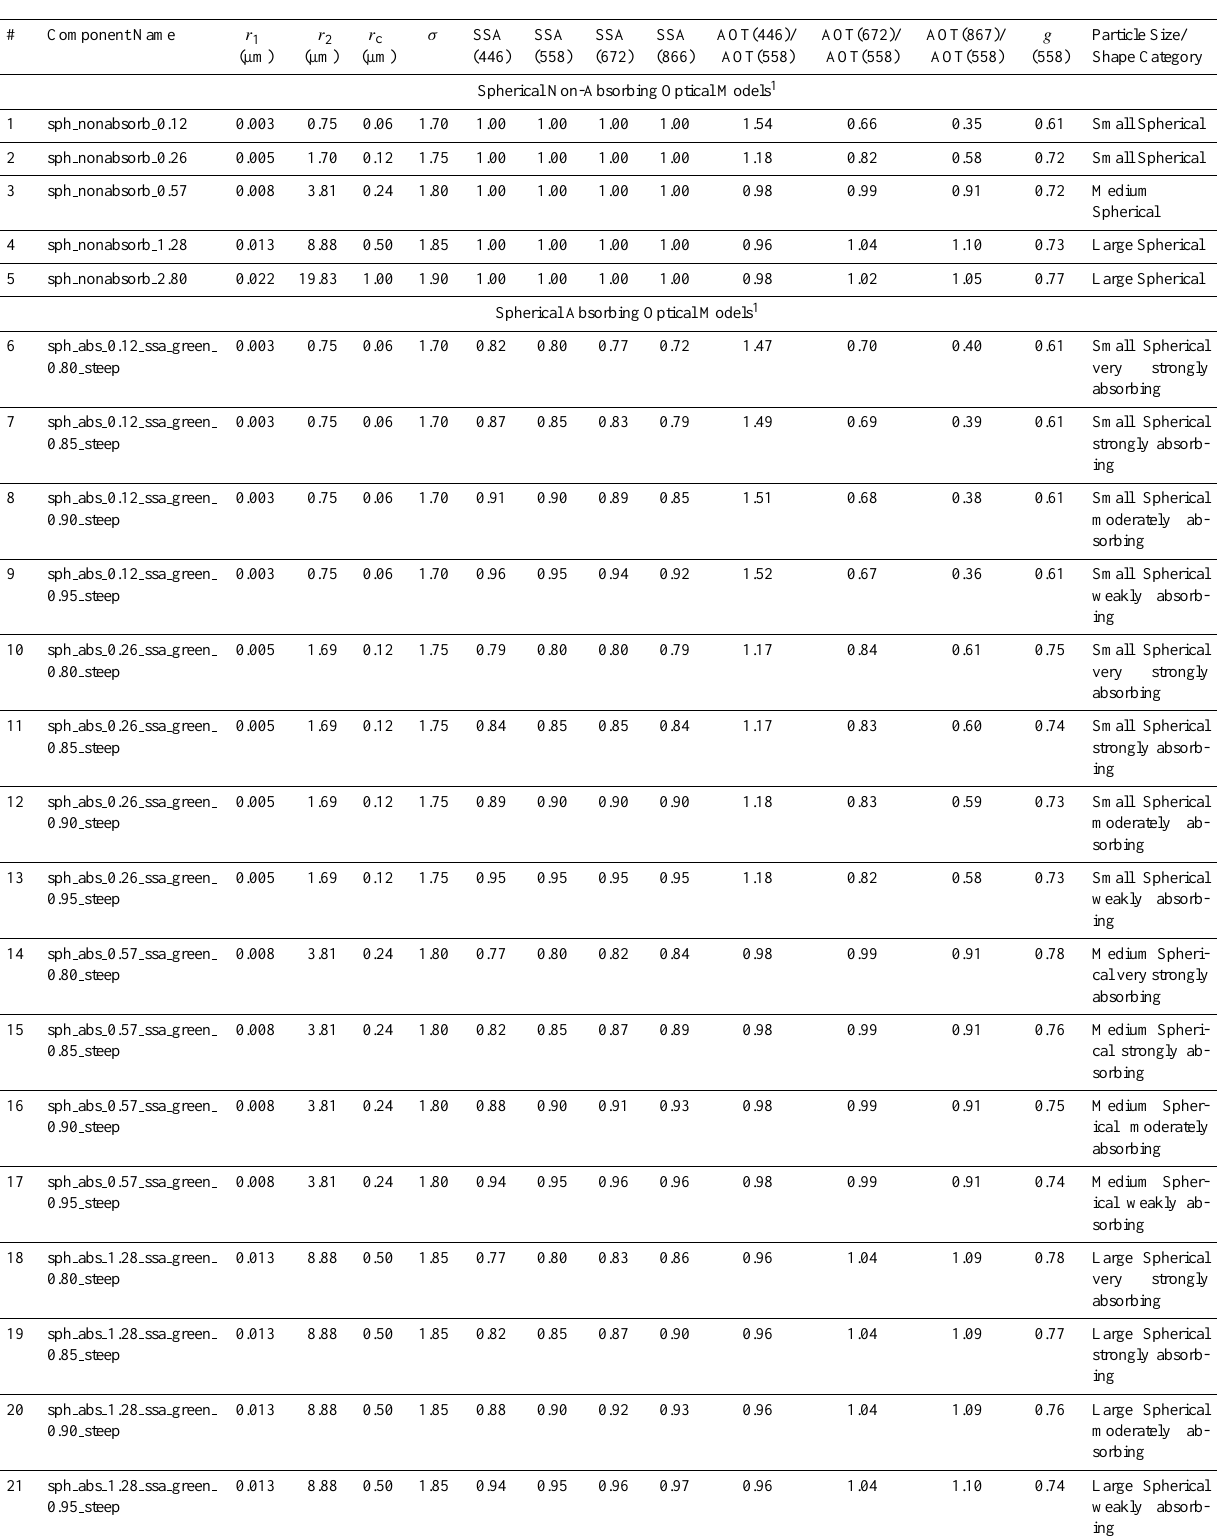
Table 2. Aerosol component optical